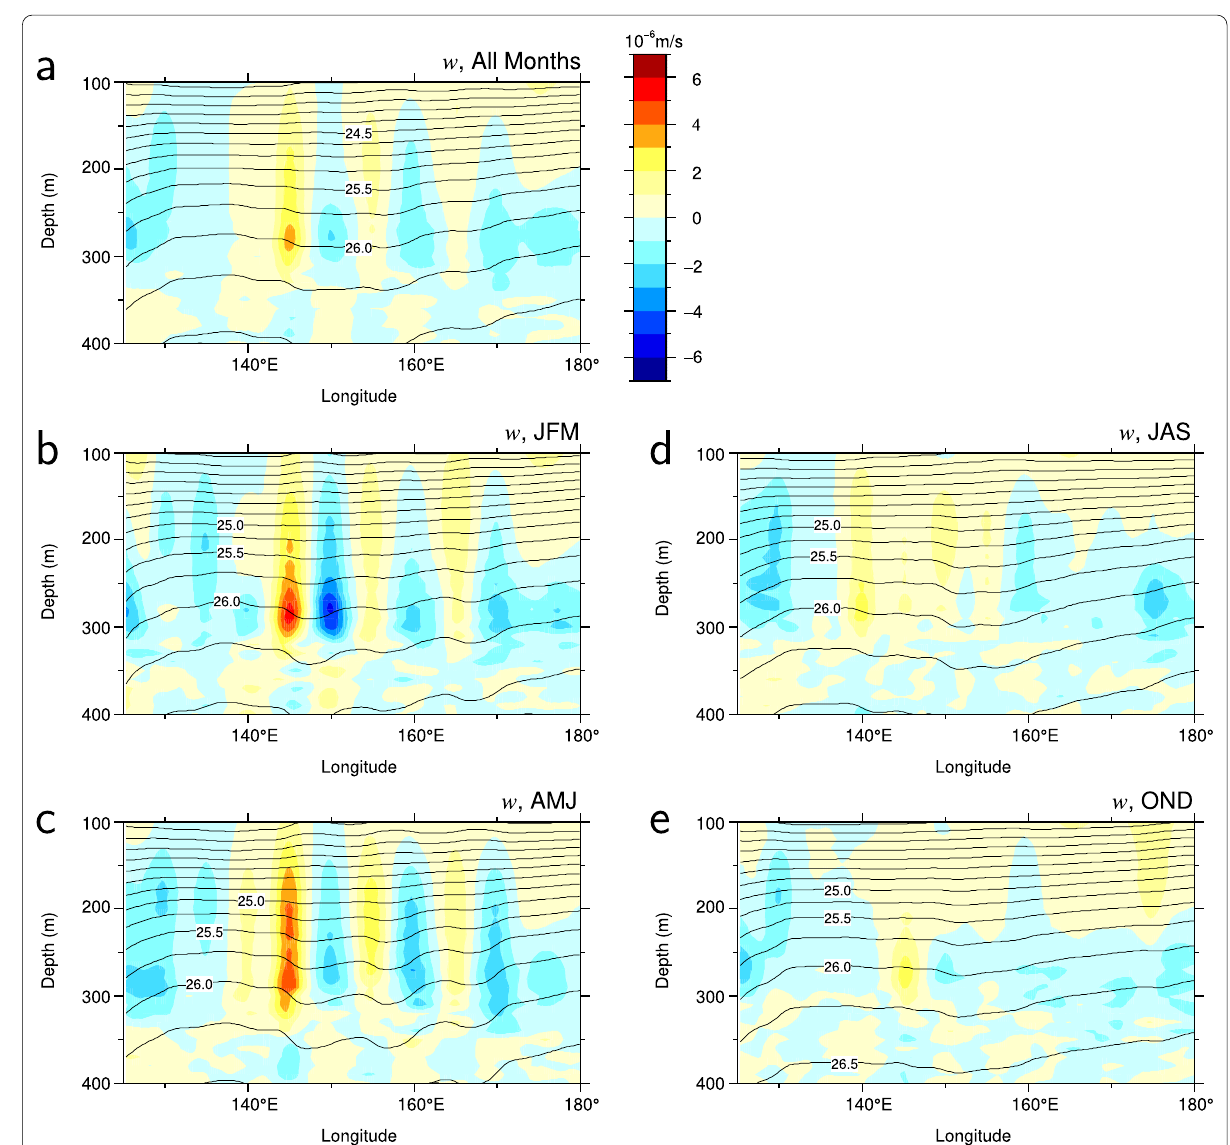
Fig. 8 Zonal sections of vertical velocity w ( ms − 1 , color shades) and potential density σ θ ( kgm − 3 , contours) at the latitude of 12.6 ◦ N averaged in